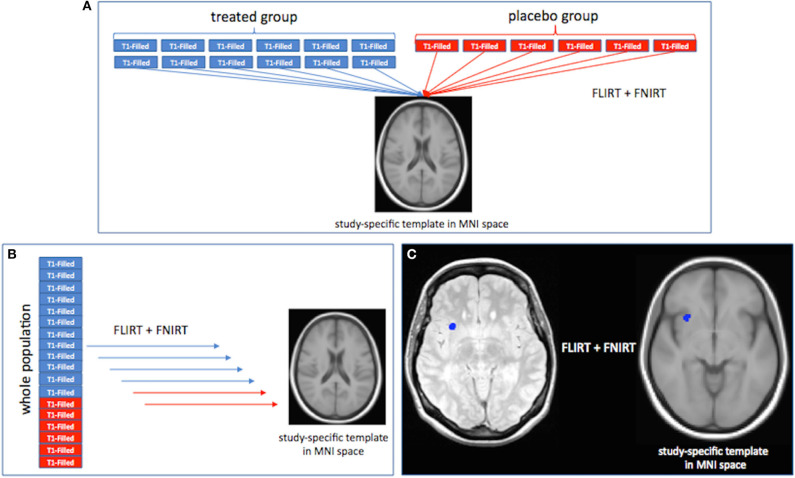
Registration workflow for the creation of the study template in standard space (A), registration onto the template of T1-weighted images, (B) and combined unique active (CUA) lesion masks (C) of all study patients. See text for details.